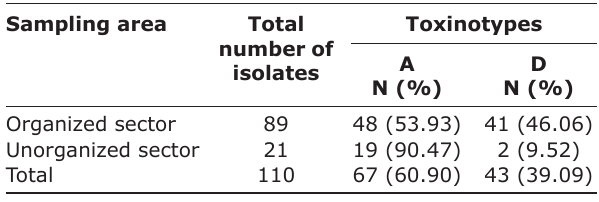
Table‑3: Prevalence of Clostridium perfringens toxinotypes in sheep under organized and unorganized rearing conditions.